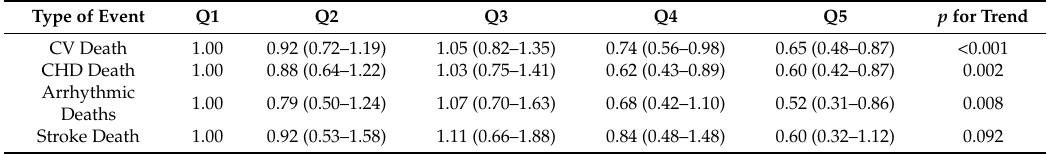
Table 2. Multivariate-adjusted associations between plasma phospholipid total long-chain omega-3